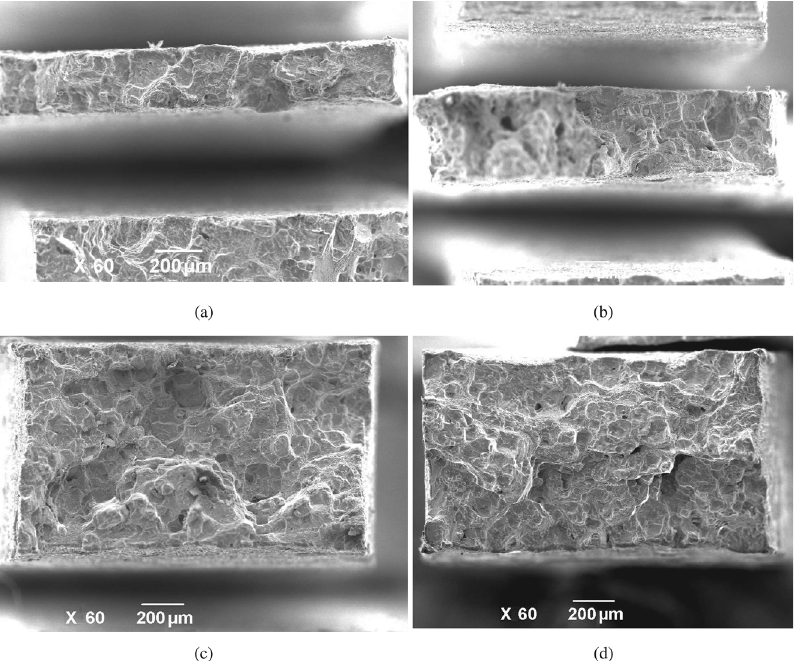
Figure 7: SEM fractograph of the specimen fracture surface. (a) δ = 0.3 mm, 1,100 ℃ /200 MPa; (b) δ = 0.6 mm, 1,100 ℃ /200 MPa, (c) δ =